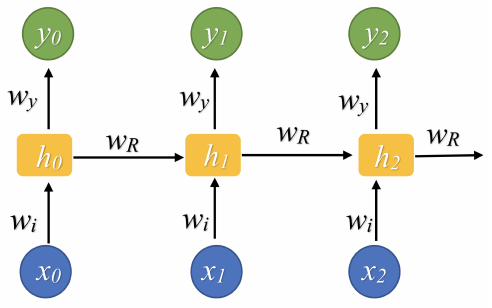
Figure 3. Simple RNN